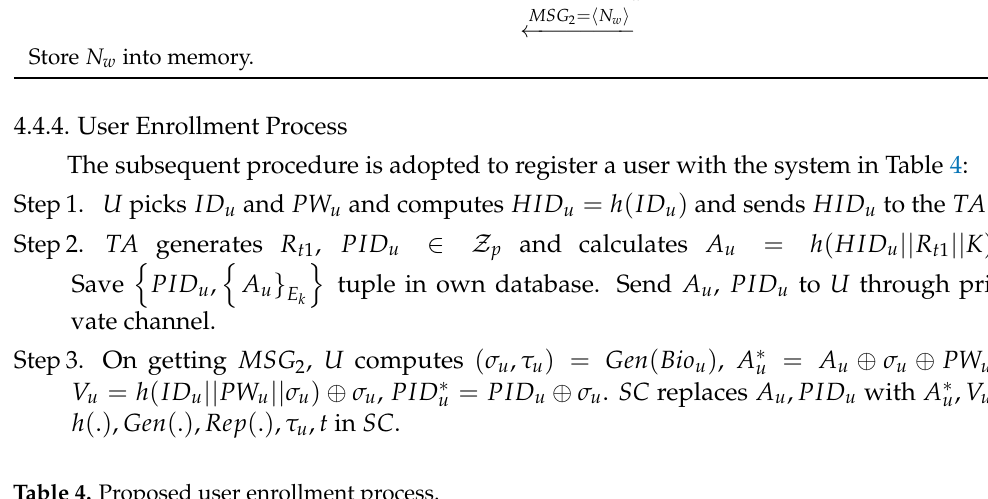
Table 4. Proposed user enrollment